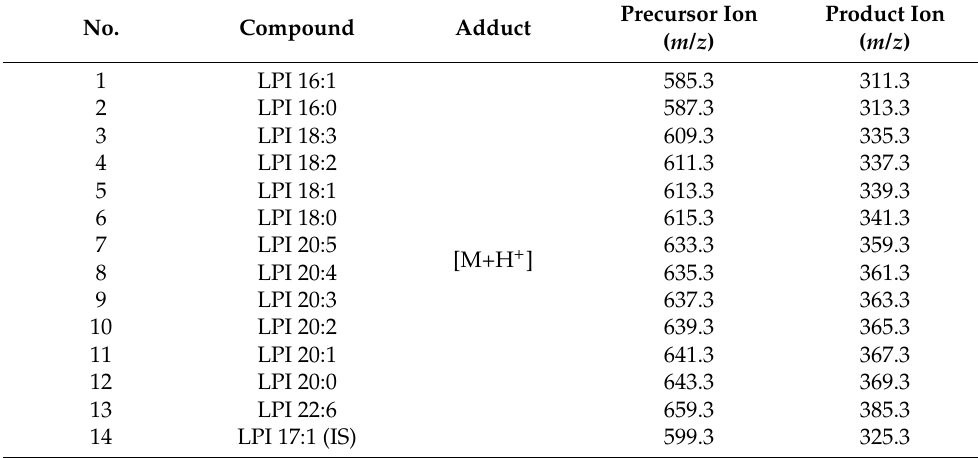
Figure 6. Levels of lysophosphatidylinositols in the livers of mice fed a normal chow diet or high-fat diet. Mice were fed a normal chow diet (NCD) or high-fat diet (HFD) for 4 weeks ( n = 5). Levels of lysophosphatidylinositols in the liver were measured. Data are expressed as mean ± SD from 5 mice for each group. * p < 0.05, ** p < 0.01, *** p < 0.001, compared with the NCD group.